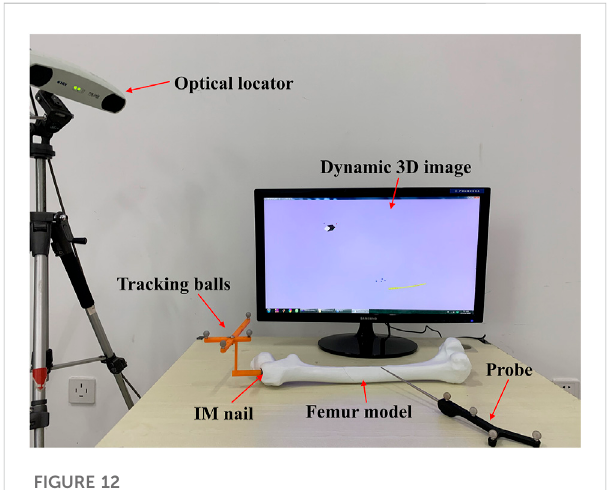
FIGURE 12 Composition diagram of distal locking